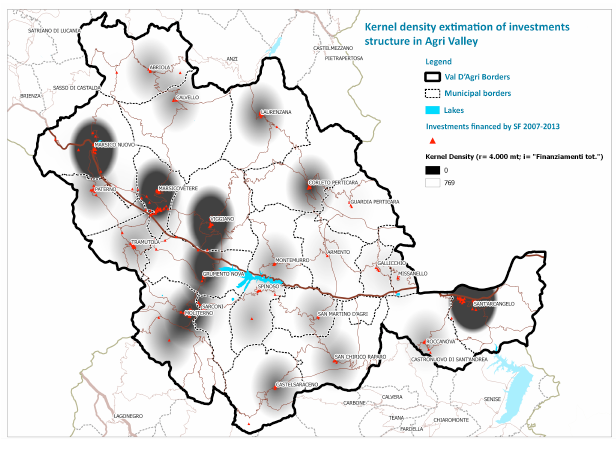
Figure 6. Investments (2007-2013) density assessment